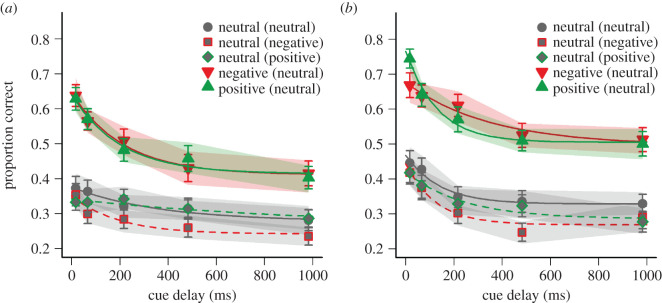
Mean verbal recall accuracy for neutral, positive and negative targets as a function of the cue delay in the first (a) and second (b) 200-trial block of experiment 1. Positive and negative targets were to be selected against neutral distractor, and neutral targets were to be selected against neutral, positive, or negative distractors (distractor valence indicated in the parentheses of the legend). Error bars depict standard errors of the mean. Solid and dashed lines represent exponential decay functions fitted to recall accuracy. The shaded areas indicate 90% CI of mean accuracy for a bootstrapped sample size of 68 participants (100 resamples).